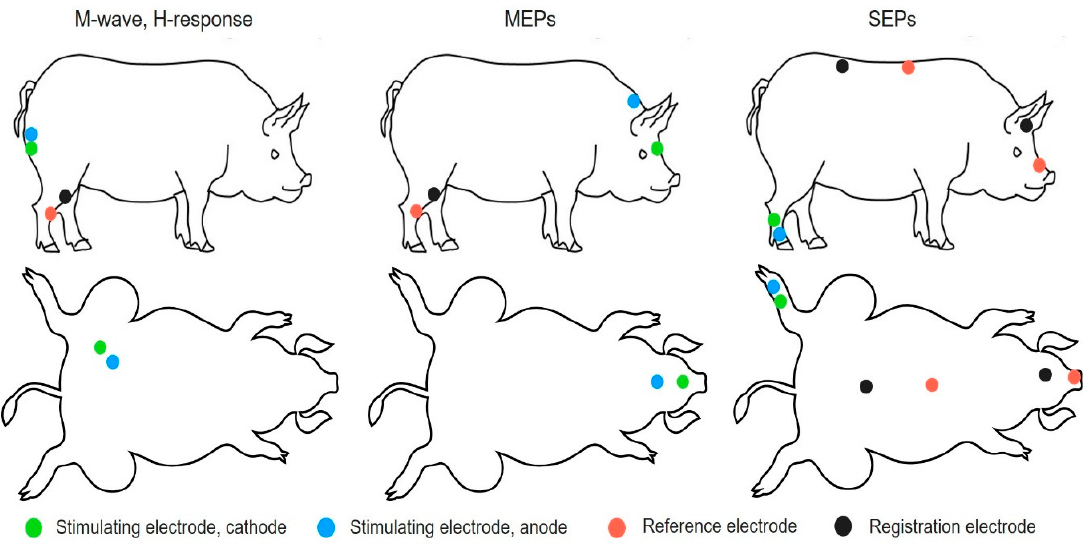
Figure 1. Schematic illustration of electrode positions in pigs.